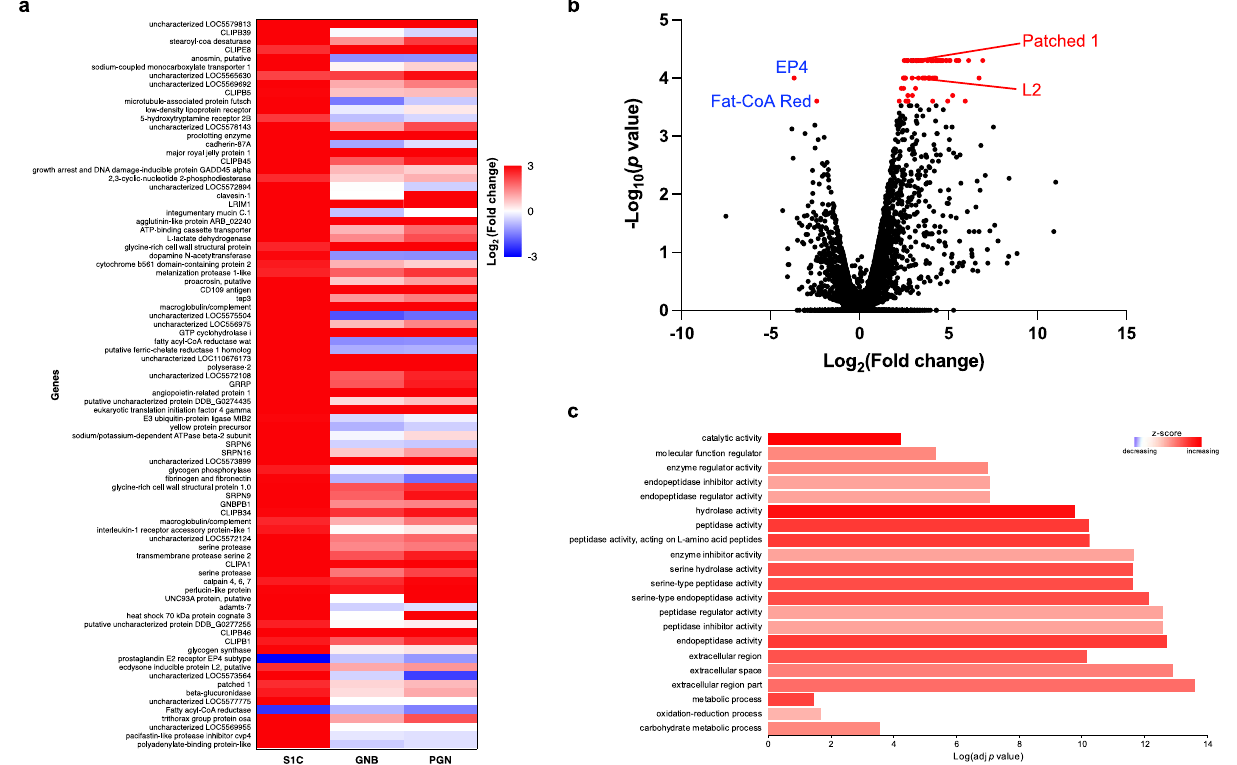
Fig.6|Spz1CtranscriptionalsignatureinAag2cellsbyRNAseqanalysis.a Heat map of genes exhibiting different responses to S1C stimulation compared to MOCK-stimulated Aag2 cells. Corresponding gene expression is also shown for Gram-negative bacteria (GNB) and PGN stimulation. b Volcano plot of individual two-sided pairwise comparisons of S1C versus MOCK-stimulated Aag2 cells expression. Signi fi cantly differentially expressed genes (DE-genes) are in red, non- signi fi cant genes areinblack. Data in a and b are represented using CummeRbund